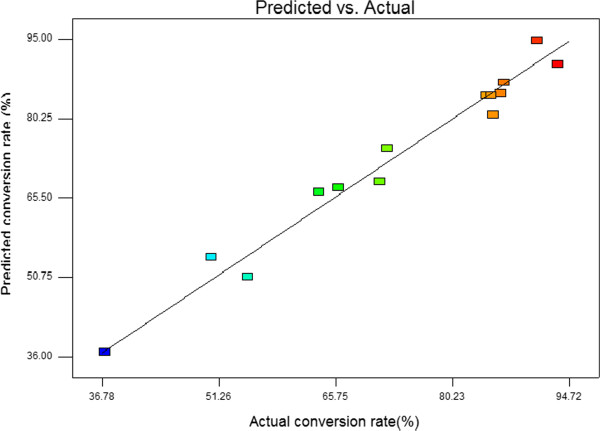
Plot of predicted and observed conversion rate (%) of D-isoascorbyl palmitate.